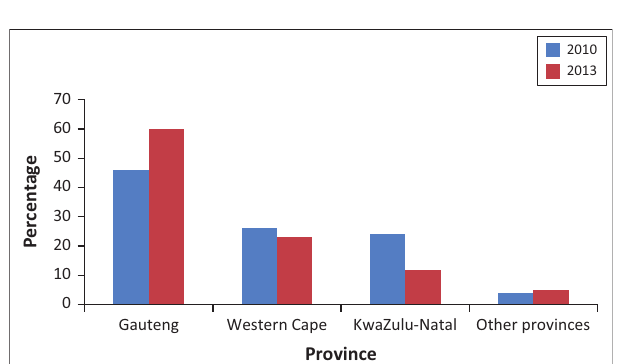
FIGURE 1: Airline choice 2013.